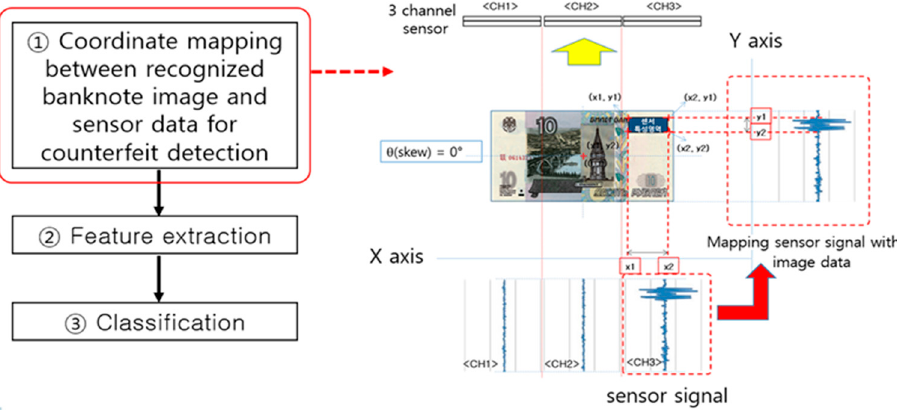
Figure 14. Example of data matching between banknote image and sensor data in the counterfeit banknote detection process flow.